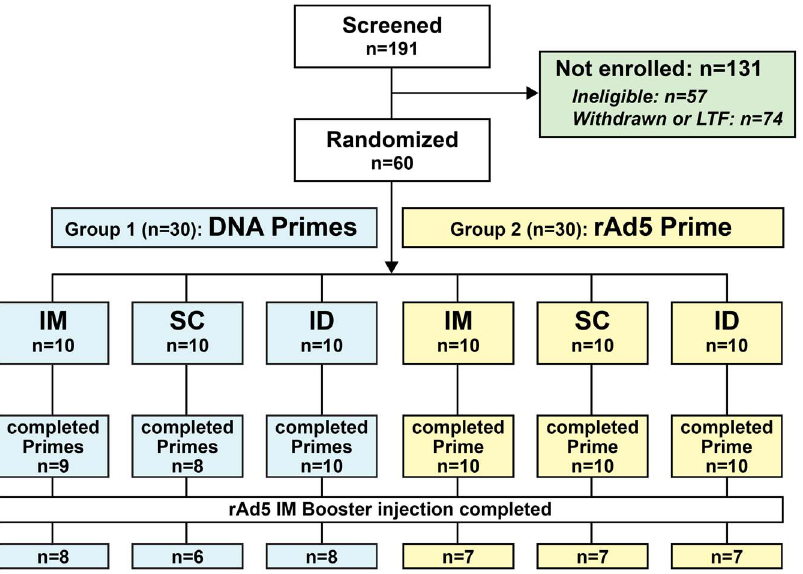
Figure 1. VRC 011 Disposition Flow Diagram of Screening, Randomization and Vaccination Completion. doi:10.1371/journal.pone.0091366.g001 PLOS ONE |